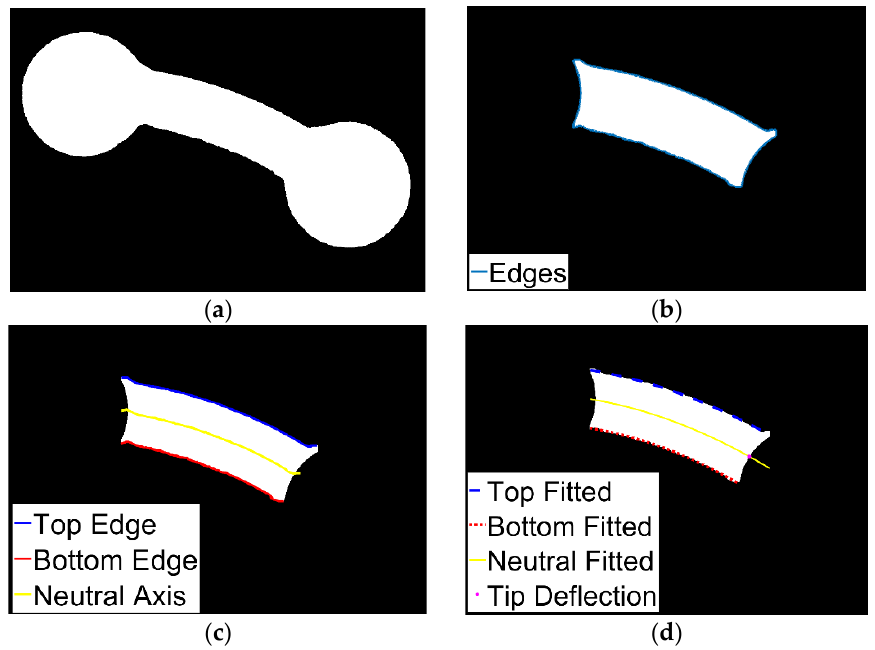
Figure 3. Specimen image processing: ( a ) images were cropped and binarized; ( b ) the cylindrical ends were identified and removed, and the edges of the middle portion were determined; ( c ) two sets of equally spaced points were created on the top (blue) and bottom (red) borders and averaged to determine the neutral axis (yellow); ( d ) the top and bottom edges and the neutral axis were fitted with 2 nd order polynomials, and the intersection of the neutral axis and the right cylindrical section was used for the tip point deflection (pink).